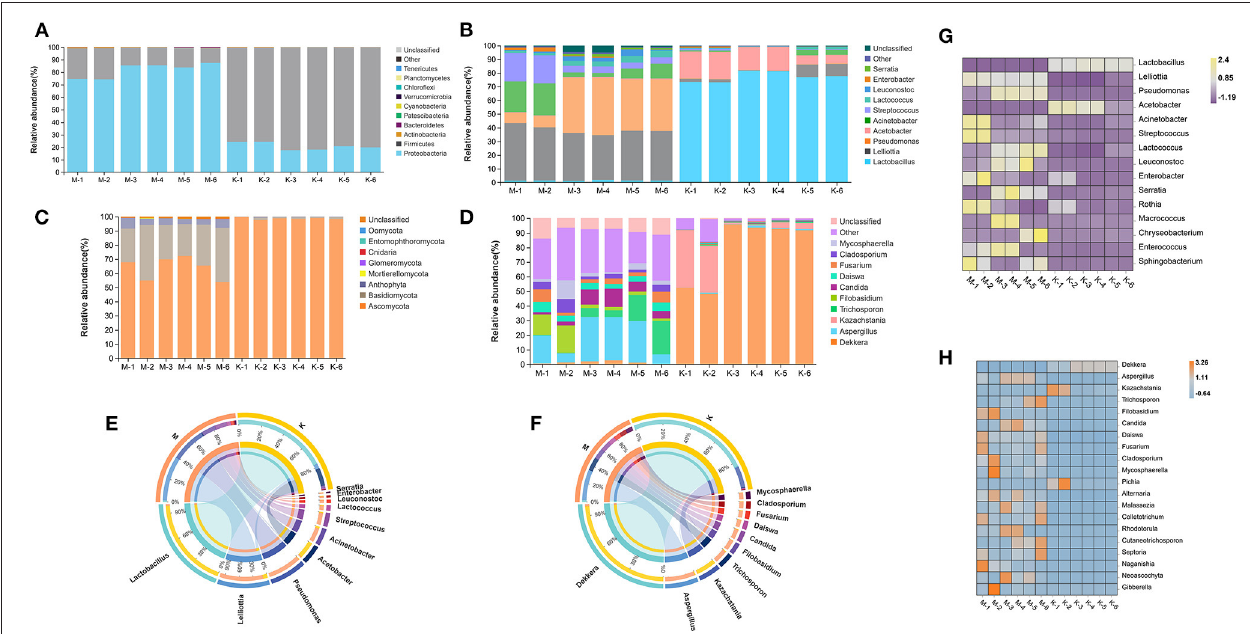
FIGURE 3 | Analysis diagram of species composition of mare’s milk before and after fermentation. (A,B) Superimposed maps of species distribution of bacteria at the phylum and genera levels, respectively. (C,D) Superimposed maps of species distribution of fungi at the phylum and genera levels, respectively. (E,F) Species distribution of bacteria and fungi at the genus level respectively. (G,H) Heat maps of bacteria and fungi distribution at the genus level, respectively.